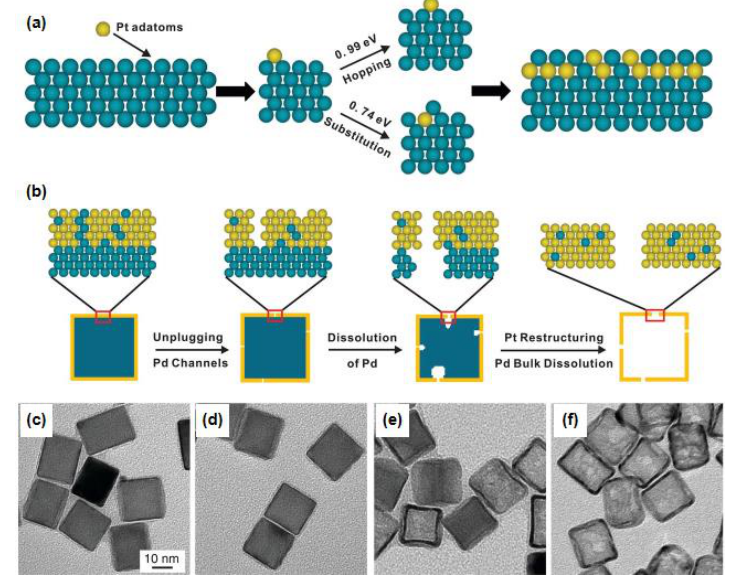
Figure 6. Scheme illustration of Pt-based nanocages with subnanometer-thick walls: ( a ) Pt atoms deposited on the Pd surface may diffuse (“hop”) across the surface or substitute into the surface, leading to a mixed outer-layer composition. ( b ) Schematic of the major steps involved in the continuous dissolution of Pd atoms from a Pd@Pt 4L cube to generate a Pt cubic nanocage. ( c – f ) TEM images of Pd@Pt 4L cubes after Pd etching for ( c ) 0, ( d ) 10, ( e ) 30, and ( f ) 180 min. Adapted from [96], with permission from AAAS, 2015. Nanomaterials 2018 , 8 , x FOR PEER REVIEW